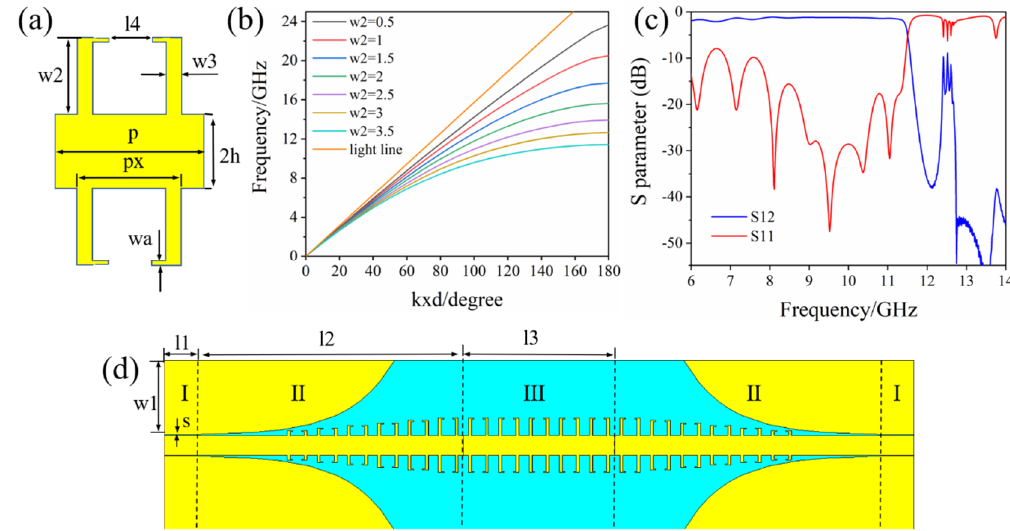
Figure 1. ( a ) The unit structure of the waveguide, whose dimensions are p = 5.3 mm, h = 2 mm, wa = 0.2 mm, px = 3.5 mm, w2 = 3.5 mm, w3 = 0.5 mm, l4 = 1.6 mm. ( b ) Dispersion relations of SSPPs waveguide with different heights. ( c ) The S parameter of the waveguide. ( d ) The schematic diagram of SSPPs waveguide, where l1 = 10 mm, l2 = 45 mm, l3 = 26.5 mm, w1 = 15 mm, s = 0.16 mm.